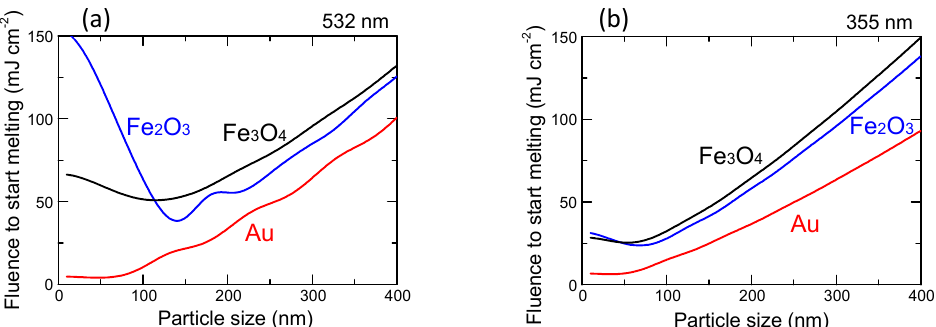
Figure 1. Particle size dependence of laser fluence required to melt a single particle of Au, Fe 3 O 4 and Fe 2 O 3 calculated based on Mie theory and adiabatic assumption. ( a ) 532 nm. ( b ) 355 nm.